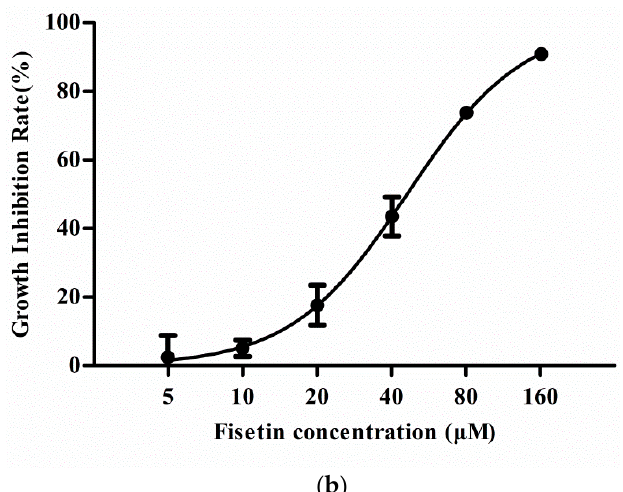
Figure 1. Effects of fisetin on HepG2 cell viability. ( a ) Chemical structure of fisetin; ( b ) HepG2 cells were incubated with different concentrations of fisetin (0, 5, 10, 20, 40, 80, 160 μ M) for 24 h, and cell viability was detected by methyl thiazolyl tetrazolium (MTT) assay. DMSO treatment was used as a control. Data are presented as the mean ± SD of three independent experiments.